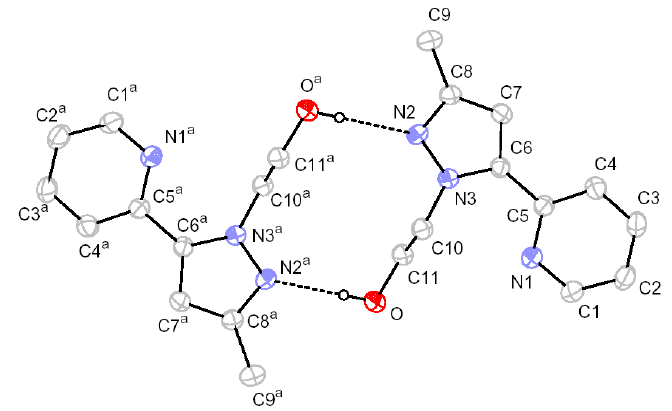
Figure 2. Molecular structure of 2 , thermal ellipsoids are represented at 30% probability. Hydrogen atoms (except that bonded to O atom) have been omitted for clarity. Symmetry codes used to generate equivalent atoms: ´ x + 0.5, ´ y + 0.5, ´ z (a).